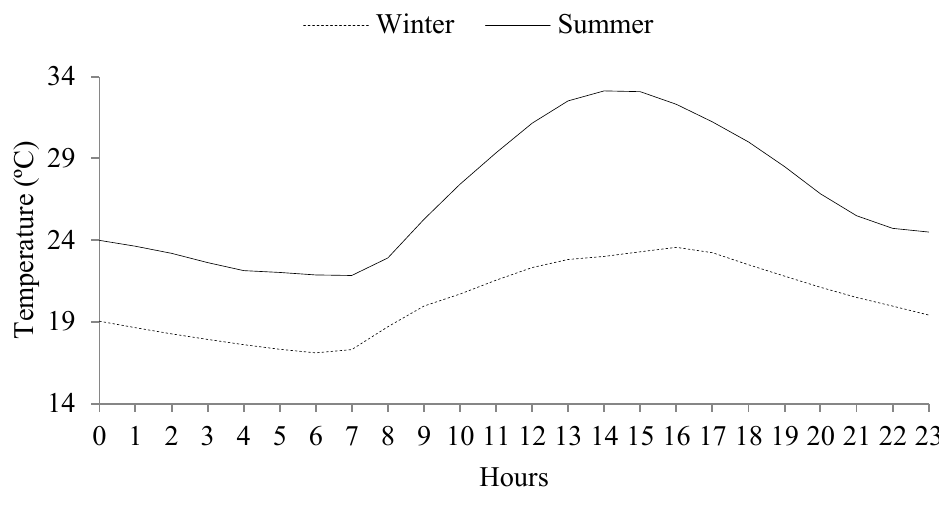
Figure 2. Temperature (°C) regarding the